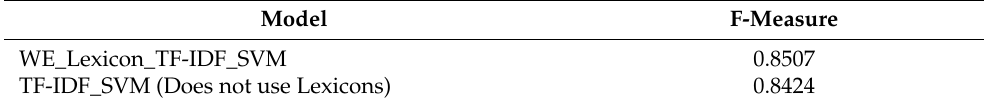
Table 10. Hybrid models outperforming the best non-Lexicon model in the Chilean-Mexican